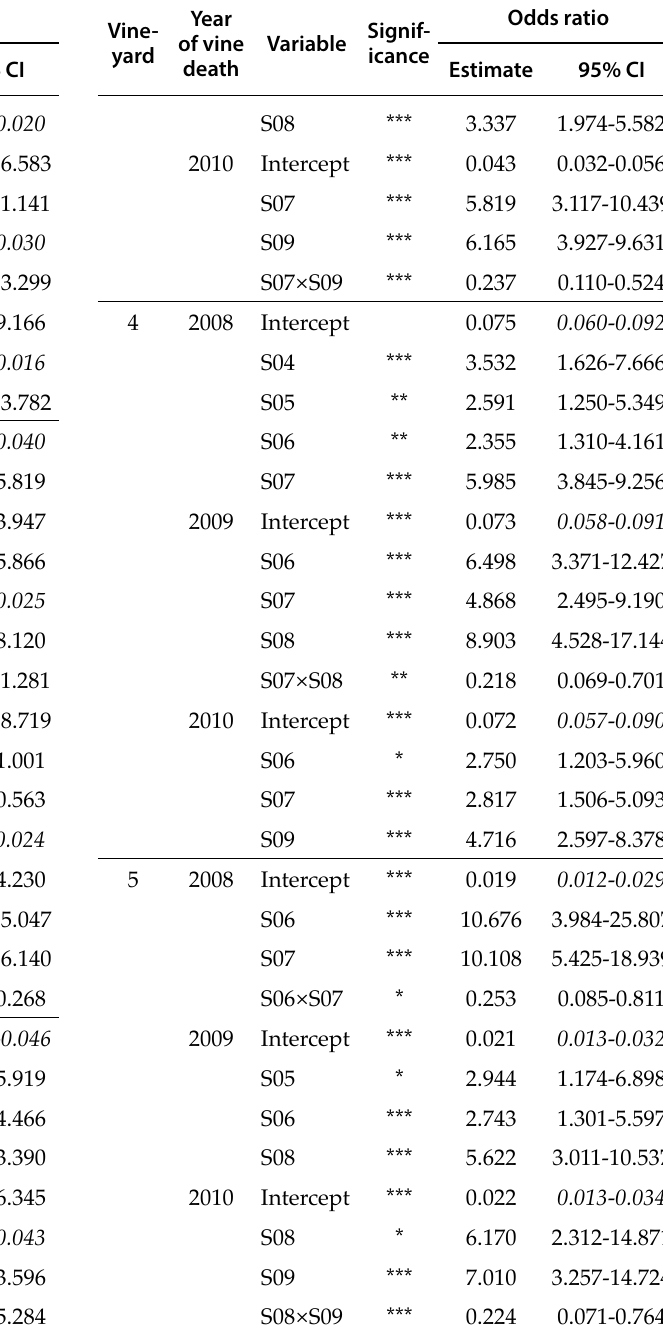
Table 2. Odds ratio (Estimate and 95% Confidence Intervals) from the best-fit binary regression logistic model that pre - dicted the risk of vine death in 2008, 2009 or 2010 based on esca symptoms (chronic or acute form) in the previous four years (i.e. s07 = symptoms in 2007) for the six vineyards. * P <0.01, ** P <0.001, *** P